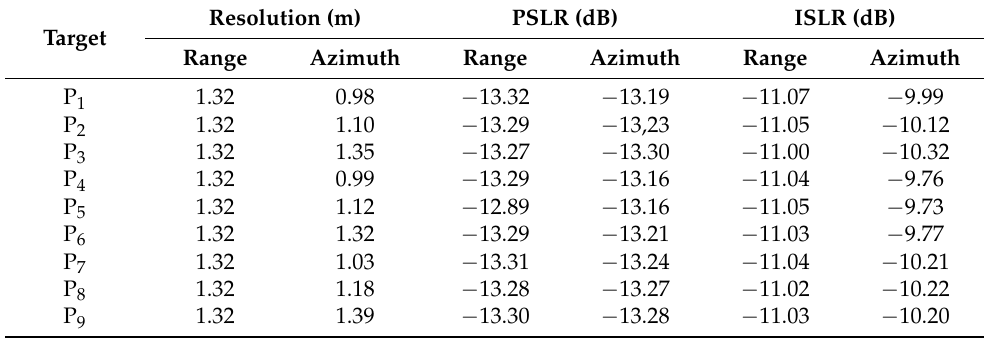
Table 4. Focusing performance evaluation of the nine point targets when using HSHD-AFBP.